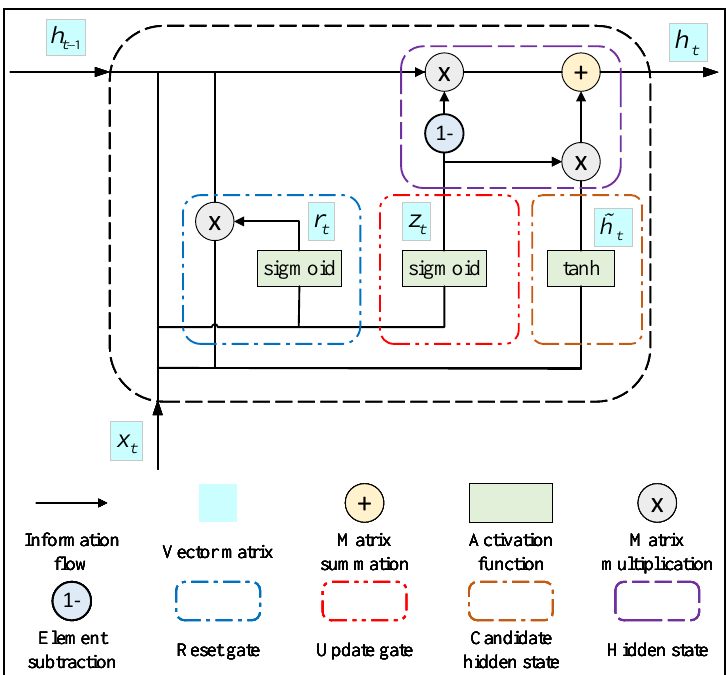
Figure 2. Internal structure diagram of GRU. The circular structure of a GRU is shown in Figure 3, which extends the feature infor- mation through multiple GRU modules to achieve the prediction of long-time sequences.